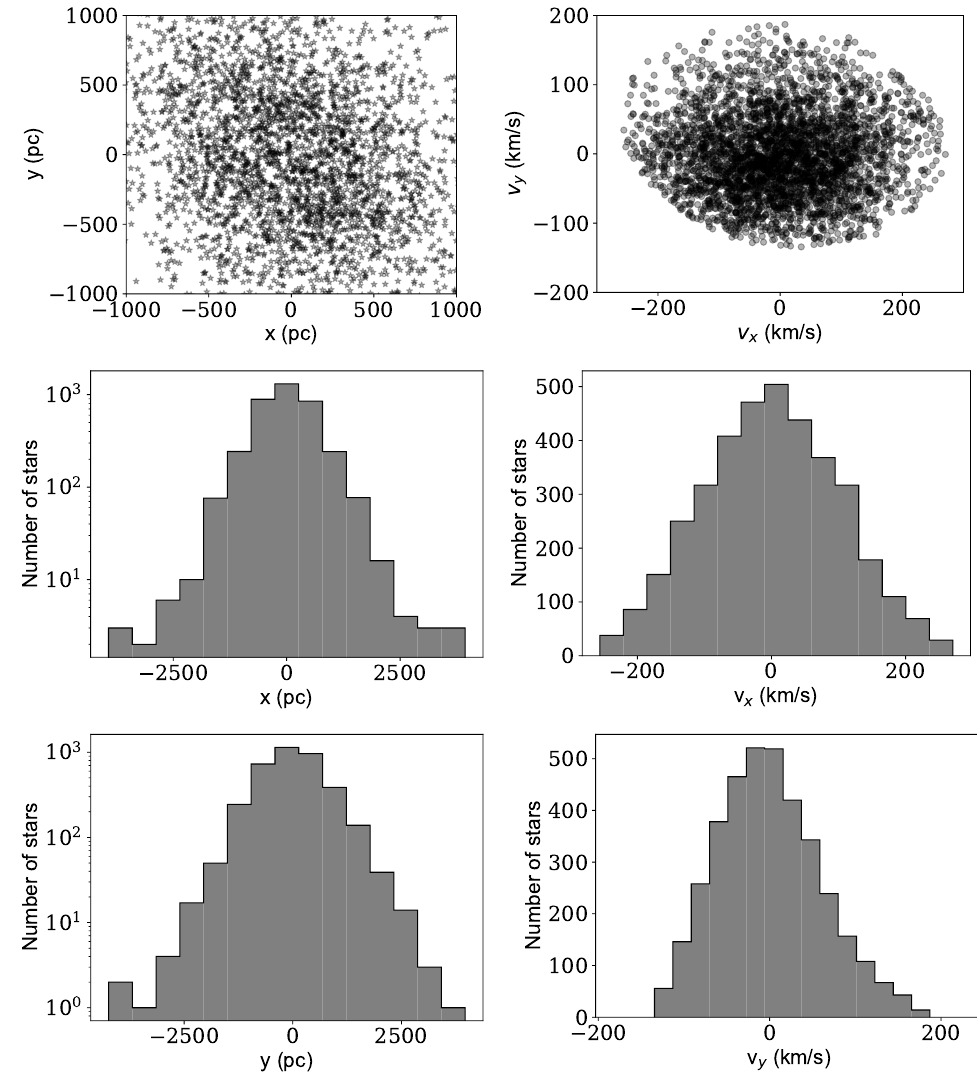
Figure A2. The position and velocity of the stars in the comoving coordinate system of the Fornax dSph. Each point in the two top plots represents a start. The rest of the plots are the histograms of the four dimensions of the phase-space. The histograms indicate that the system is fairly spherical. The height and the width of the histograms of x and y are approximately equal supporting the spherical symmetry in the position-space. The same is approximately valid for v x and v y histograms supporting the spherical symmetry in the velocity-space. The reason we have used a cylindrical symmetry to carry out the Jeans equations in Section 4 is the slight discrepancy between the width, but not the height, of v x and v y